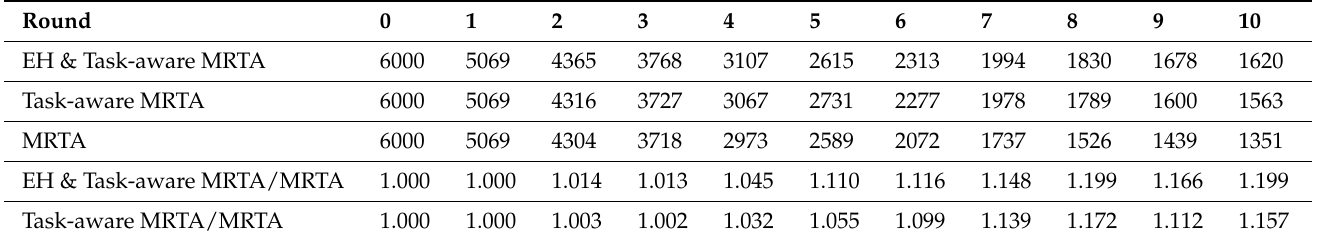
Table 3. The total remaining energy in the batteries of the 10 robot nodes, which are located initially as given in Figure 4 versus the number of rounds under Poisson EH